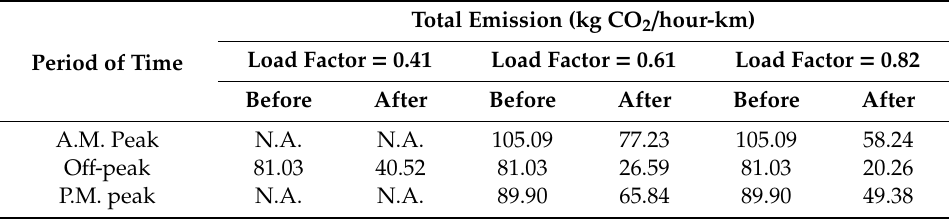
Table 3. Total CO 2 Emissions Before and After Reform of the Bus Network.